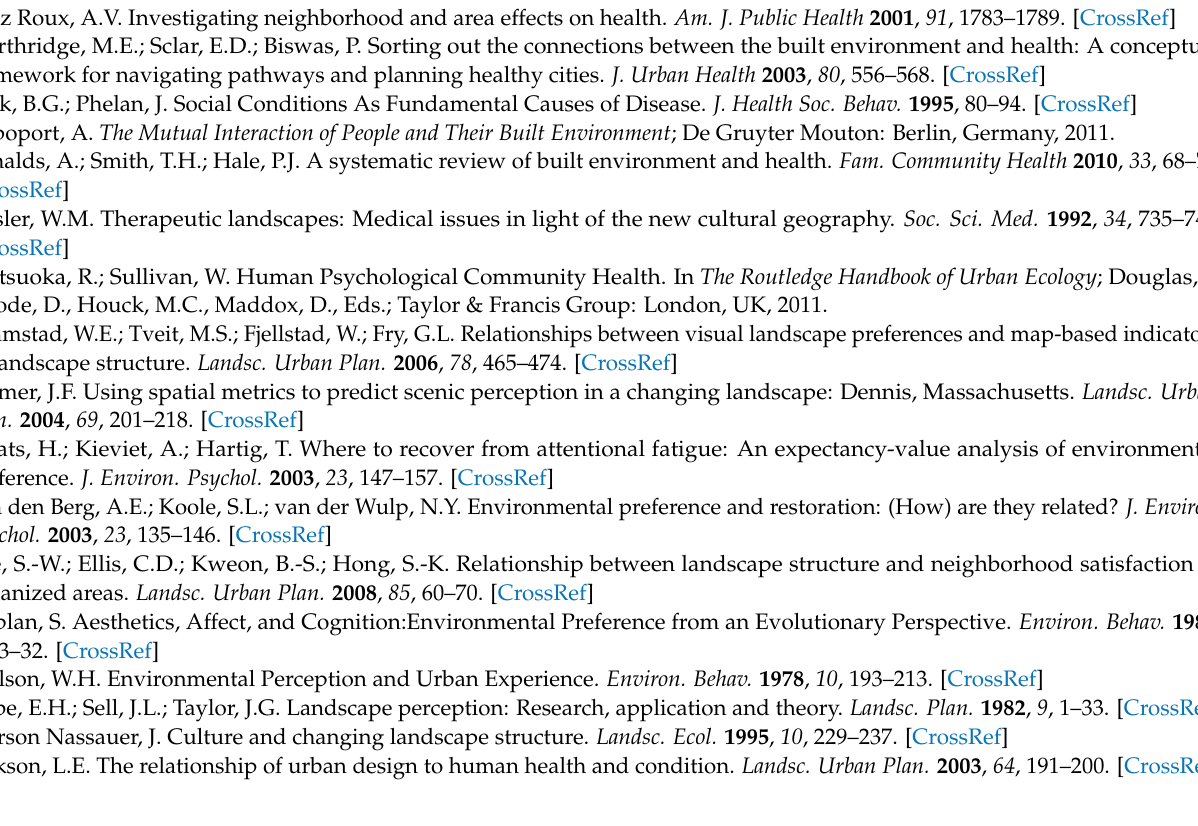
model. Figure S1: Distribution of population density by municipality and interpolated density of colon cancer patients’